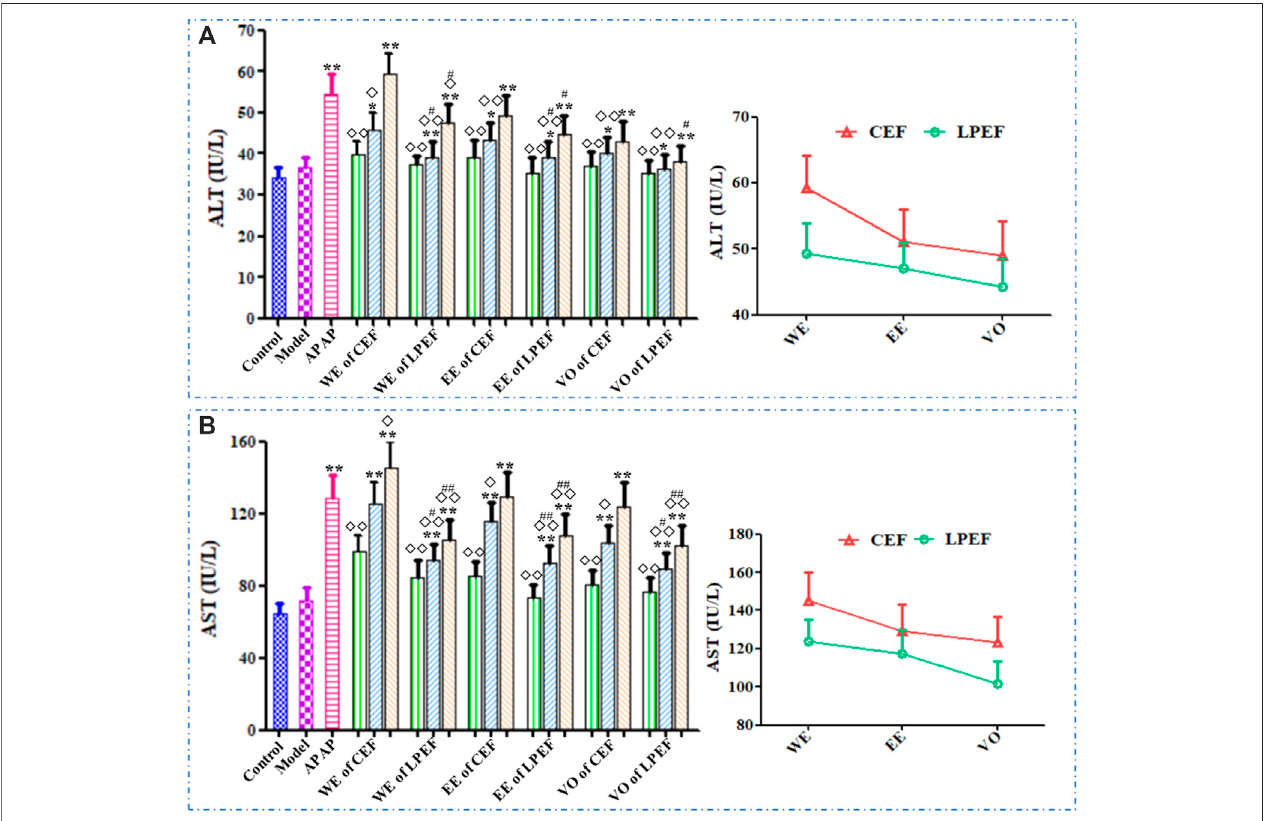
FIGURE6| Effectson serum ALT (A) and AST (B) activities ofdifferentdrugs. Leftgraph:comparison between21groups; right graph:comparison betweenthree CEF and LPED extracts at high dose. Values are mean ± SD of 10 replicated samples; vs. control group, p < 0.05 ( * ) and p < 0.01 ( ** ); vs. CEF, p < 0.05 ( # ) and p < 0.01 ( ## ); vs. APAP, p < 0.05 ( ◇ ) and p < 0.01 ( ◇◇ ). 10.5 g kg − 1 , 5.25 g kg − 1 , 1.05 g kg − 1